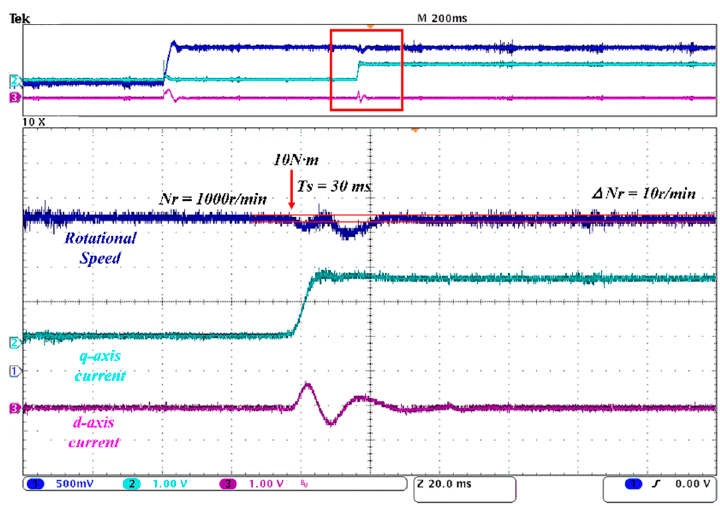
Figure 7. PMSM stator three phase current waveforms.